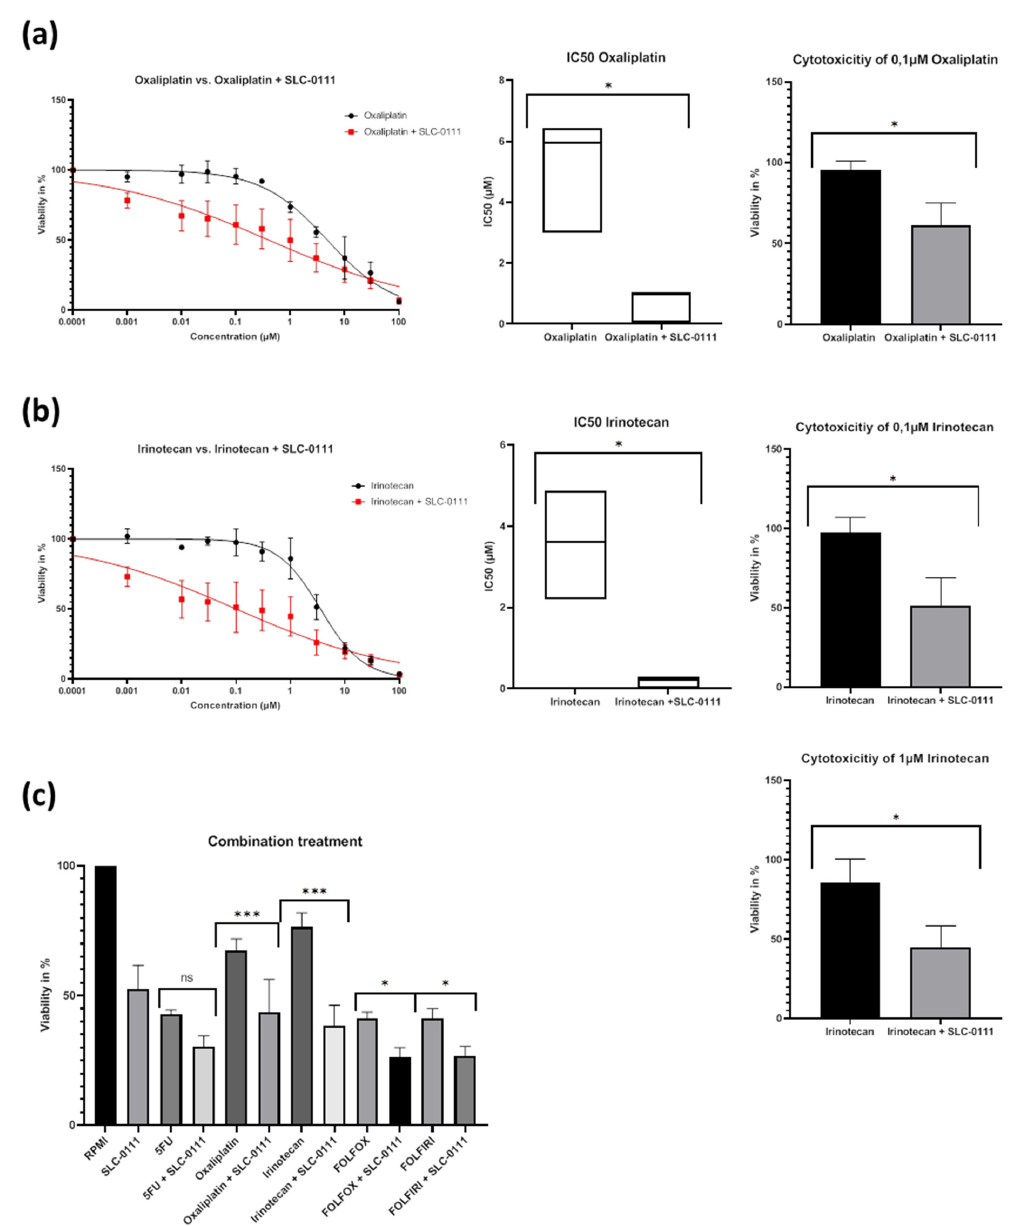
Figure 4. Impact of SLC-0111 co-treatment on chemotherapy in HT29 spheroids. ( a ): Co-treatment of oxaliplatin and SLC-0111 results in significant decrease in IC 50 value (µM, median with range, n ≥ 3) and cell viability at oxaliplatin concentration of 0.1 µM (mean with SD, n ≥ 3). ( b ): Co-treatment of irinotecan and SLC-0111 results in significant decrease in IC 50 value (µM, median with range, n ≥ 3) as well as cell viability at irinotecan concentrations of 0.1 µM and 1 µM, respectively (both mean with SD, n ≥ 3). ( c ): Additional treatment with 20 µM SLC-0111 results in significant decrease in cell viability in spheroids treated with 0.1 µM irinotecan and 0.1 µM oxaliplatin as well as spheroids treated with combinations of chemotherapeutic agents reflecting the FOLFOX (1 µM 5-FU; 0.1 µM Oxaliplatin) or FOLFIRI (1 µM 5-FU; 0.1 µM irinotecan) regimens (all mean with SD, n ≥ 3). (*: p ≤ 0.05, ***: p ≤ 0.001.)